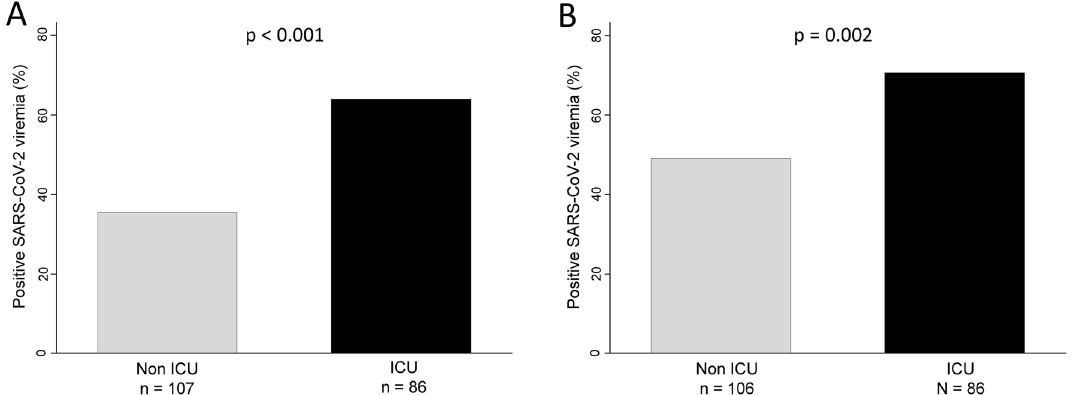
Figure 1. Detection of SARS-CoV-2 RNA in serum (viremia) is more frequent in patients requiring intensive care unit (ICU) admission. ( A ) Roche technique. ( B ) Thermo Fisher Scientific technique. Statistical significance was determined with the Chi squared test. For one of the patients TFS determination could not be performed due to lack of